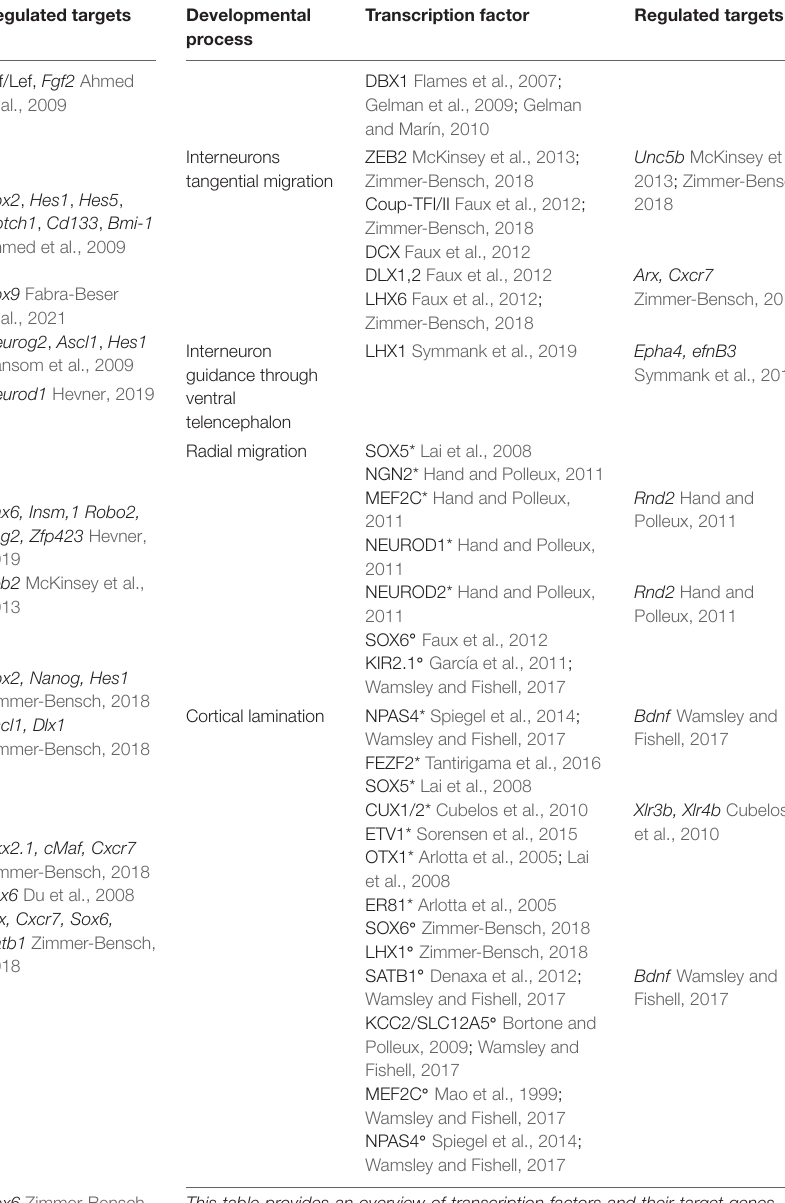
TABLE 1 | Transcriptional regulation in mammalian